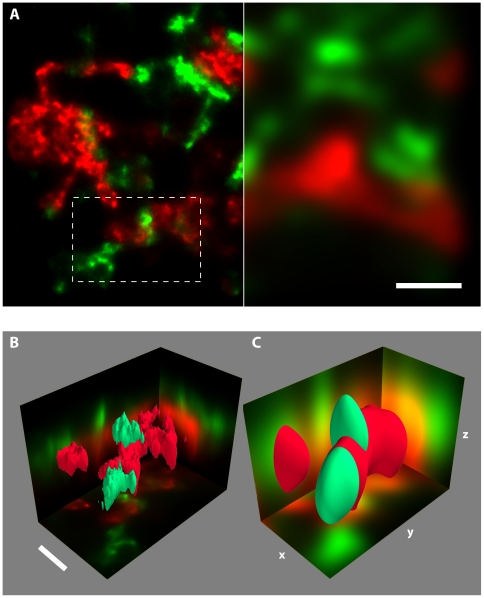
3D super-resolution imaging of GFP-alpha-SAP97 (antibody labelled with an Alexa 647 secondary, green) and Synapsin (with an Alexa 750 secondary, red) in a primary hippocampal culture.4D imaging was performed using dual-colour 3D localisation based on astigmatism in conjunction with the ratiometric multi-colour approach. A. Comparison between detail in a super-resolution image (left) with the corresponding conventional diffraction limited image (right) of the two proteins. B & C. 3D rendering of the region indicated in A using super-resolution (B) and conventional resolution (C). Note that in the high resolution data (B) ‘lateral’ as well as ‘axial’ synapses can be distinguished. The 2D images shown on the axes are average projections along the respective directions. Scale bars A: 1 µm, B: 500 nm.